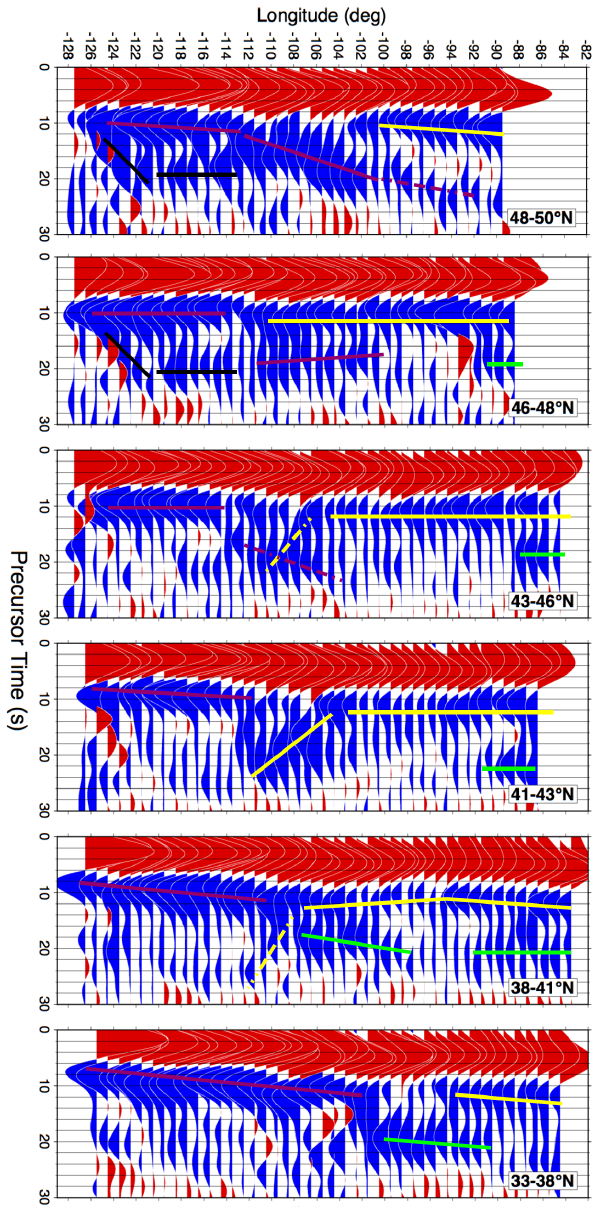
Figure 10. West–east S-receiver function profiles in the time do- main. The latitude of the distribution of piercing points in 200km depth is marked in each panel. The data are filtered with an 8s low- pass filter. Correlated phases are marked with the same colors as in Figs. 8 and 9, except that here black represents the LAB of the Juan de Fuca plate.